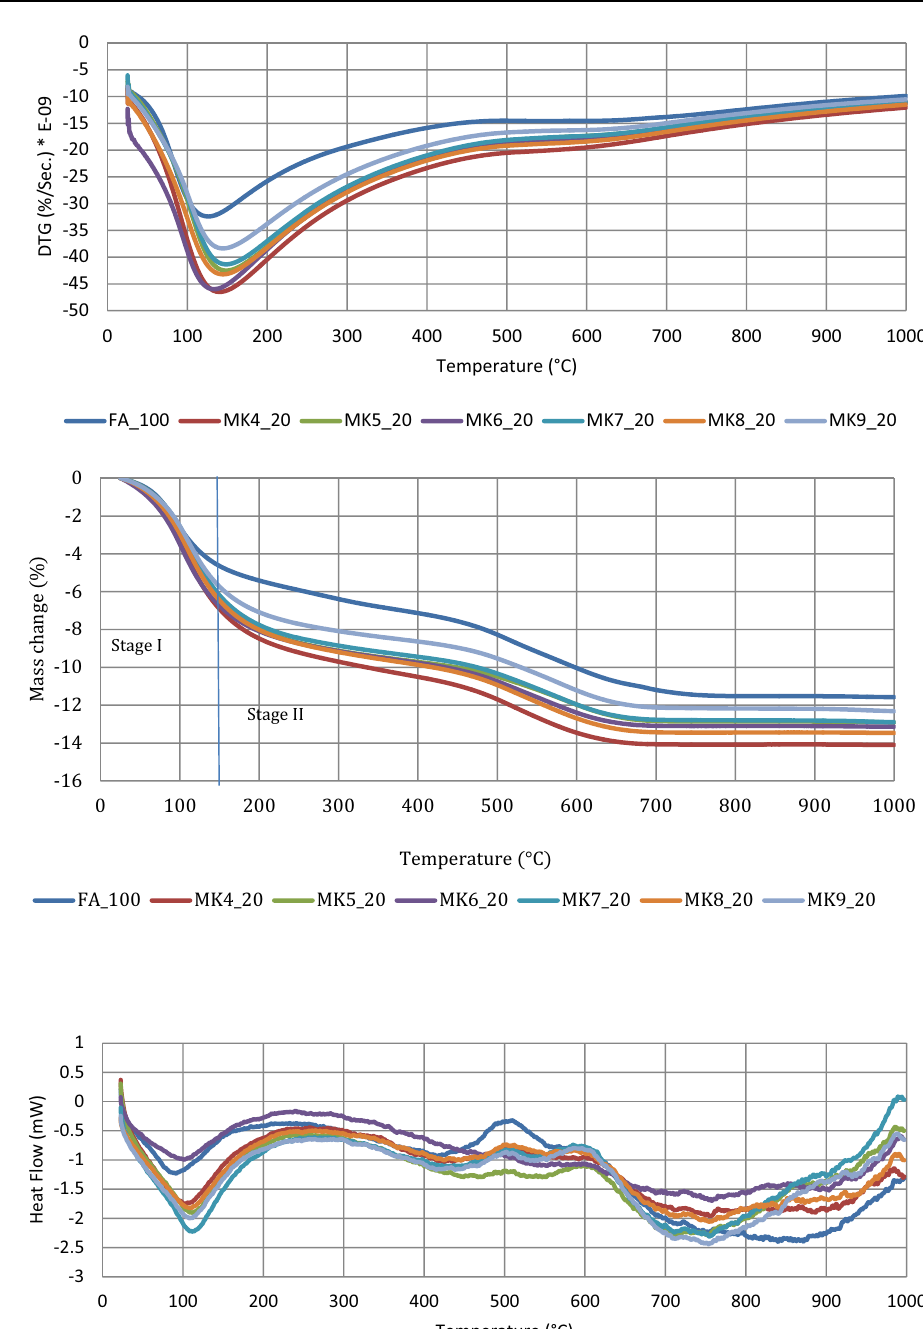
Fig. 9 TG-DTG representing 2 stages of mass loss for geo- polymer pastes investigated